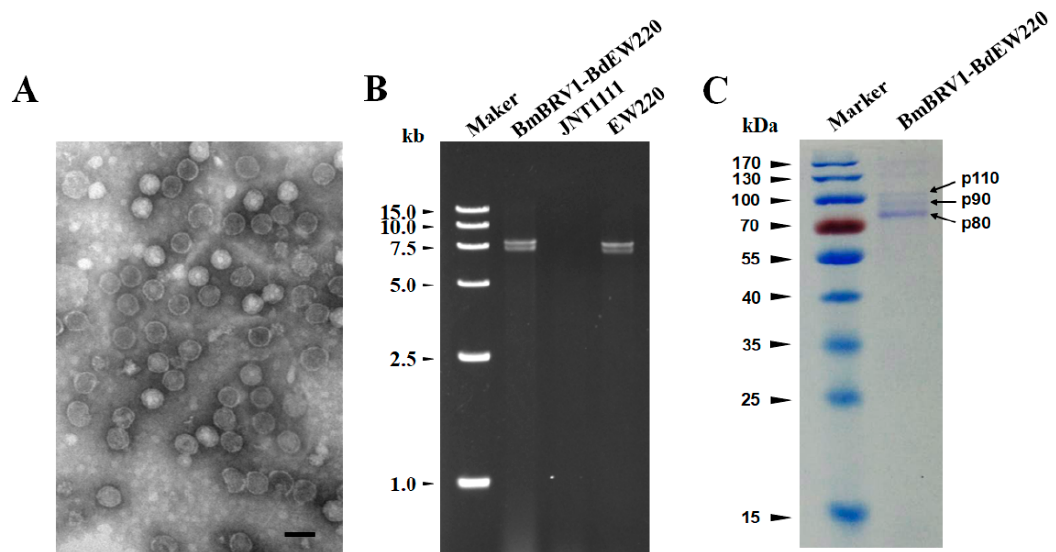
Figure 5. Features of the BmBRV1-BdEW220 viral particles ( A ) Transmission electron microscopy (TEM) images of the BmBRV1-BdEW220 viral particles; ( B ) agarose gel electrophoresis of the dsRNAs extracted from purified virus particles of BmBRV1-BdEW220 and the mycelia of strain EW220 (line EW220); ( C ) SDS-PAGE analysis of the purified viral particles shows the three distinct protein bands. The scale bar represents 50